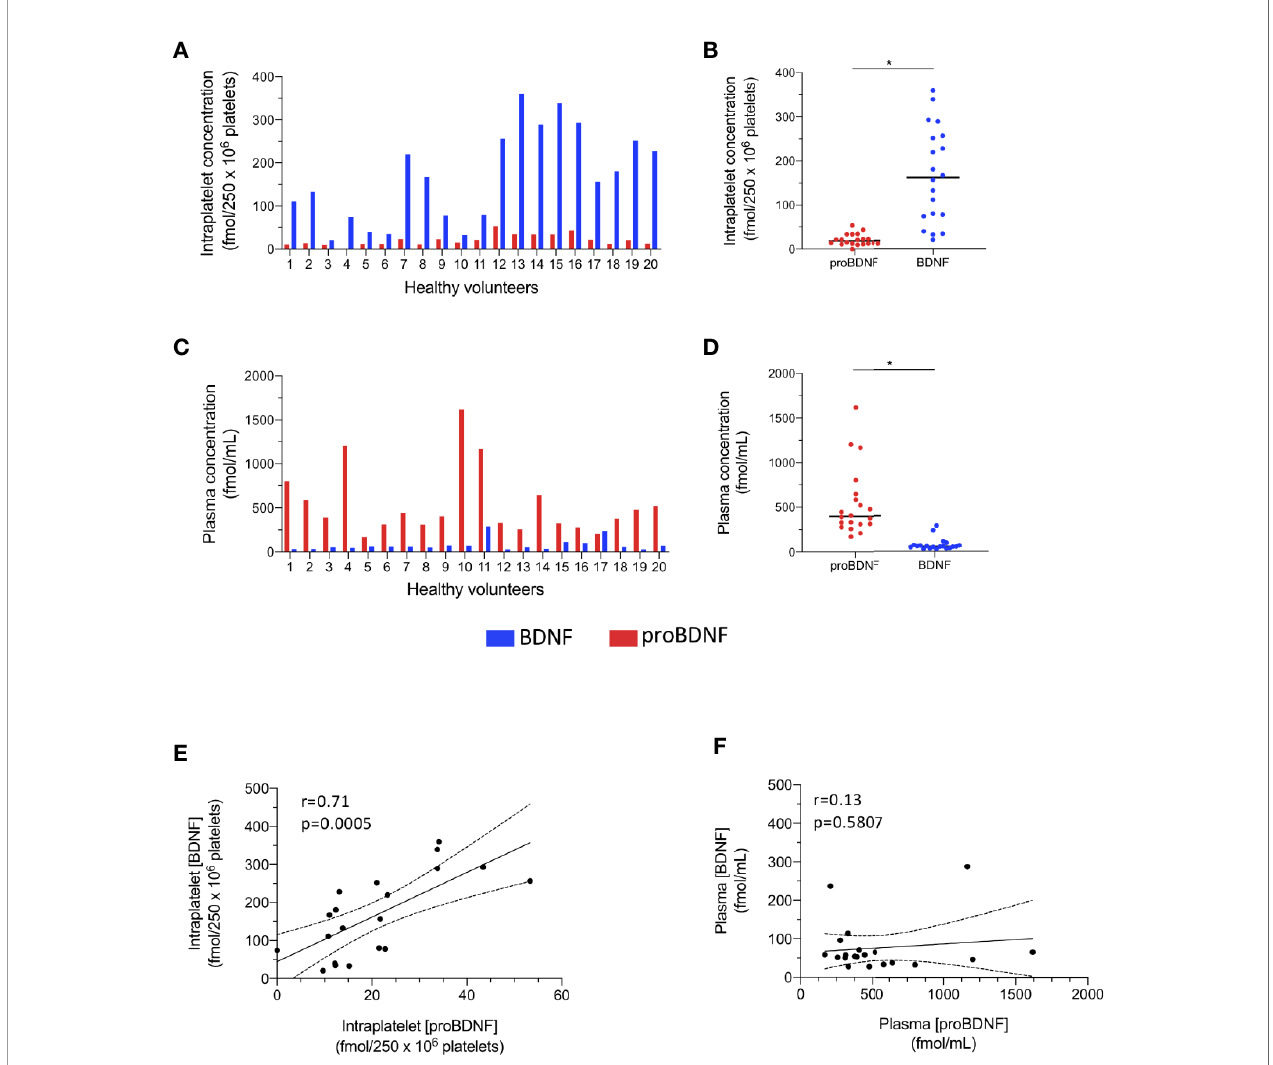
FIGURE 2 | Molar concentrations of proBDNF are lower in platelets and higher in plasma than those of BDNF. ELISA quanti fi cation of proBDNF and BDNF levels in the intraplatelet (A, B) and plasma (C, D) compartments. Concentrations are normalized for 250 x 10 6 platelets. Horizontal bar represents median, *p<0.05. (E, F) Correlation between BDNF and proBDNF molar concentrations in human platelets (E) and in plasma (F) . Dotted lines represent 95% con fi dence intervals, n=20 participants (#1 to #20).